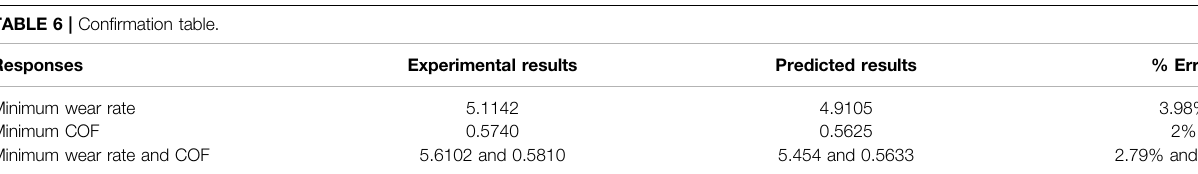
TABLE 6 | Con fi rmation table.